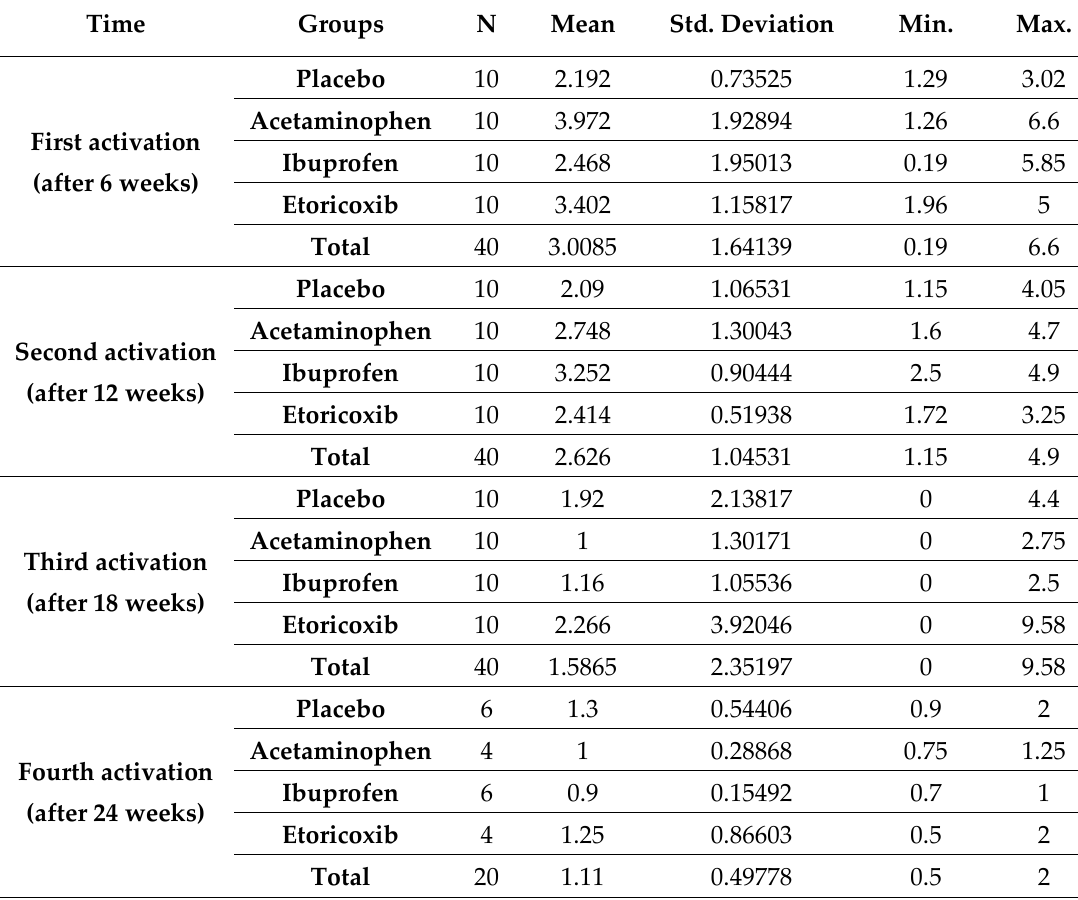
Table 3 Descriptive statistics of the rate of teeth movement in drug groups. Time Groups N Mean Std. Deviation